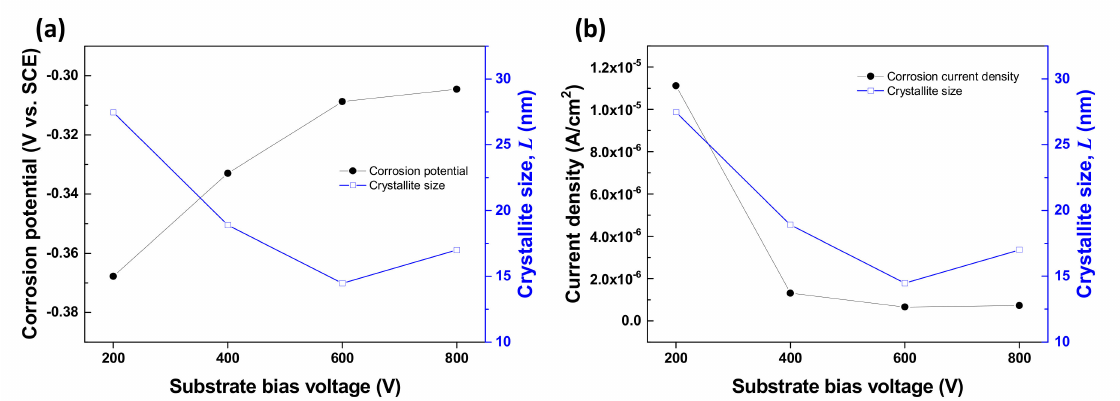
Figure 6. The effect of crystallite size variation on the corrosion ( a ) potential and ( b ) current density. The effect of bias voltage on the strain of the coated layer was investigated. Figure 7 presents macrostrain and microstrain of Nb-coated SS316L, which were obtained by